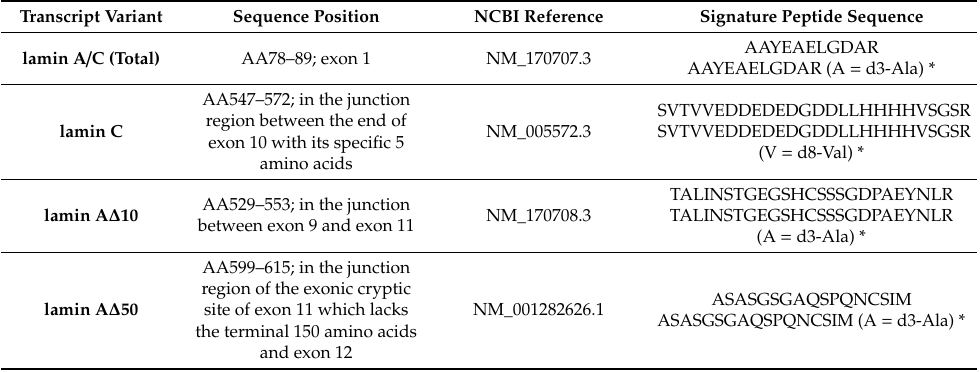
Figure 6. Locations of signature peptides on lamin A/C exons, marked by circles. Table 6. Amino acids sequences of lamin A/C gene transcript variant signature peptides.